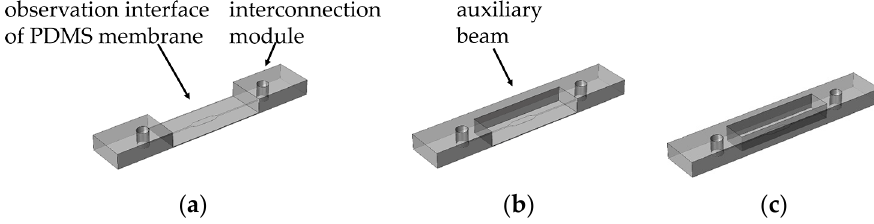
Figure 2. Three kinds of PDMS replicas structures with observation interface of PDMS membrane: ( a ) Replica A without auxiliary beam; ( b ) Replica B with one auxiliary beam; ( c ) Replica B with two auxiliary beams.